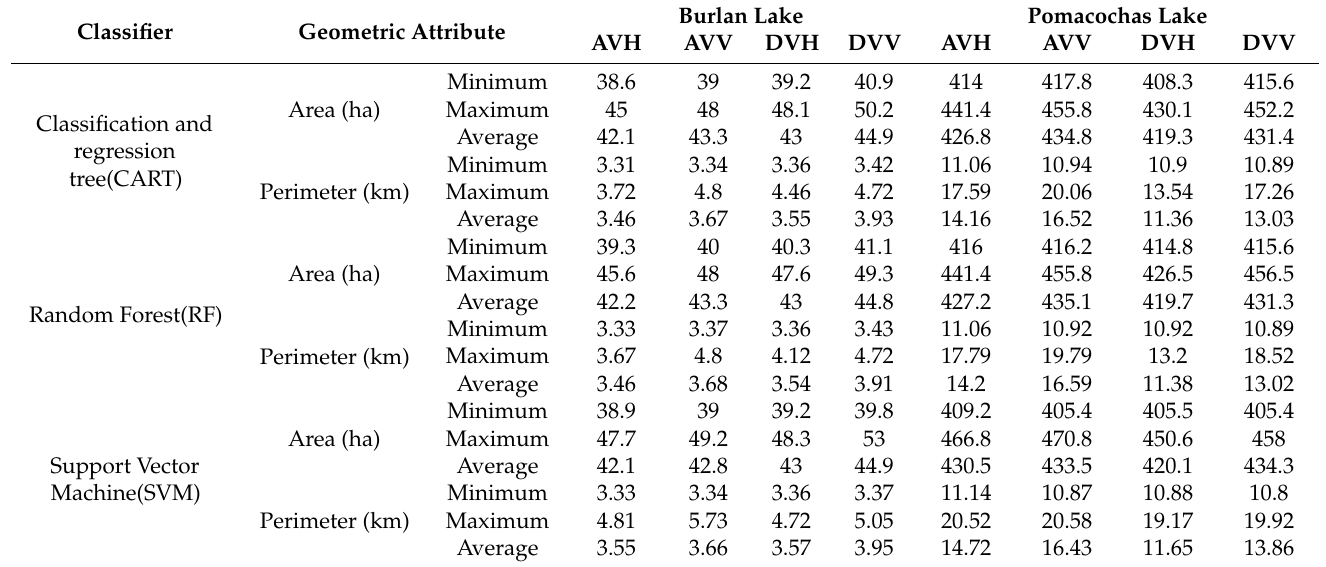
Table 2. Minimum, maximum, and average values of the area and perimeter of the Burlan and Pomacochas lakes obtained by classification of SAR images in the 2014–2020 period.